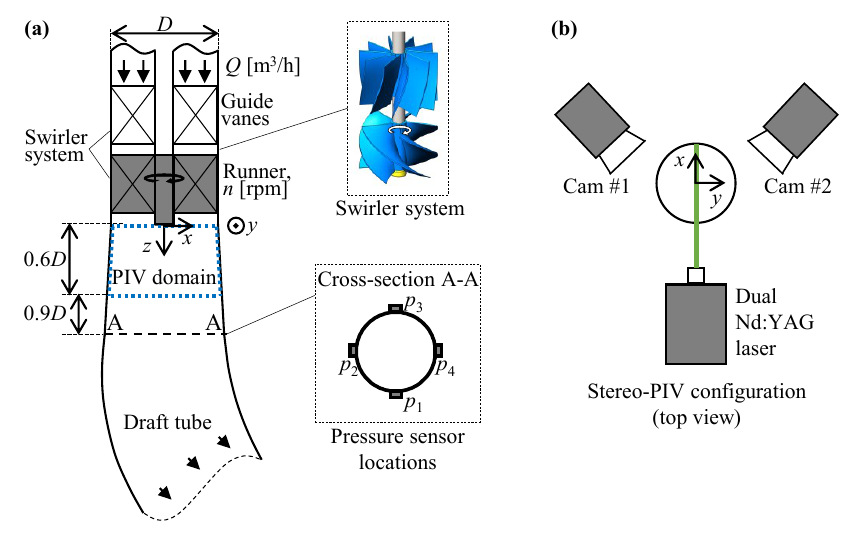
Figure 1. Test section with indicated measurement domain ( a ) and stereo-PIV configuration ( b